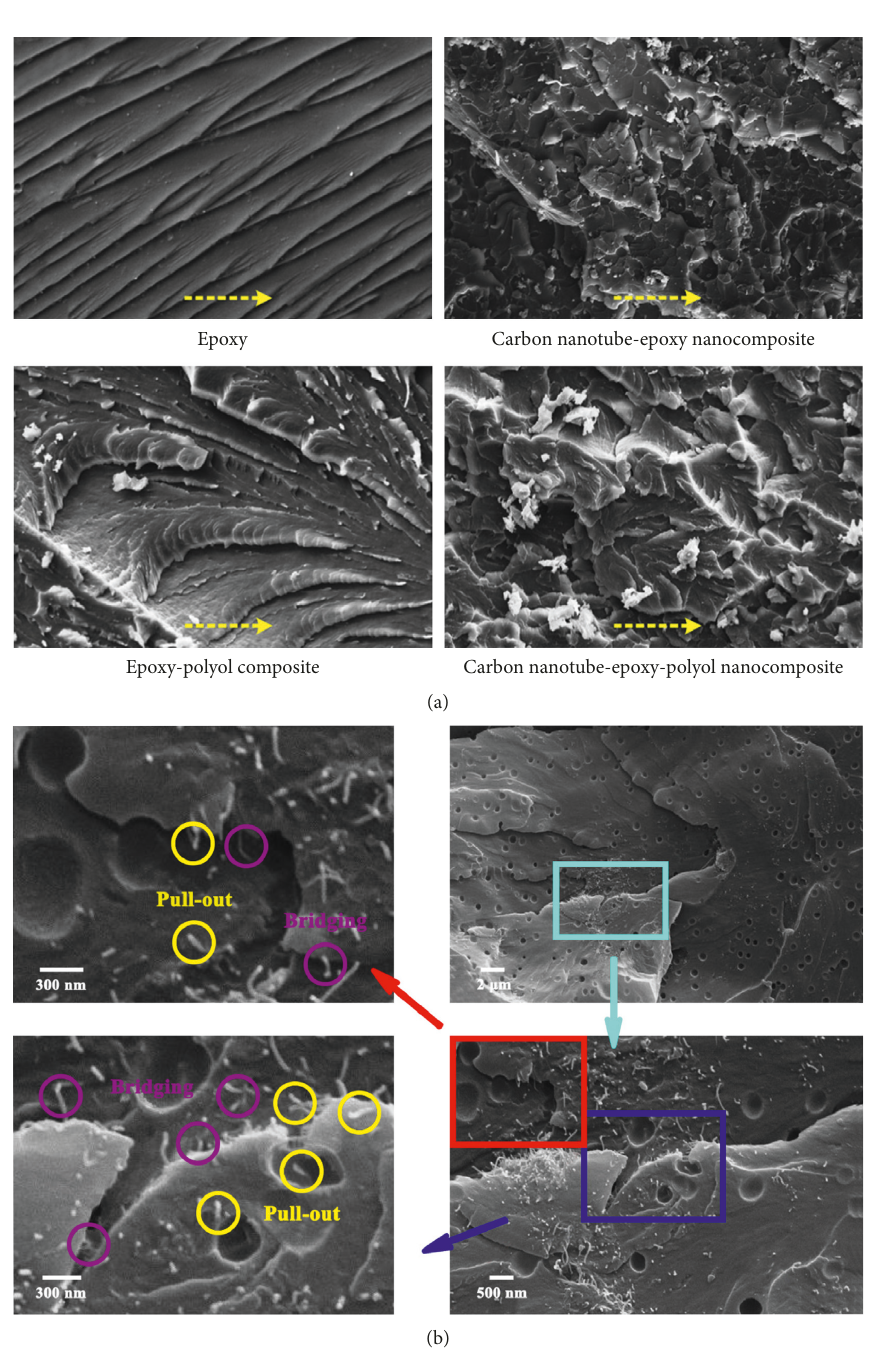
Figure 14: (a) Morphology of the quasistatically fractured surfaces characterized by a scanning electron microscope for neat epoxy and chemically modified epoxy composites. (b) Morphology of the quasistatic fracture surface characterized by a scanning electron microscope for an epoxy-polyol hybrid nanocomposite reinforced with multiwalled carbon nanotubes, illustrating a bridging phenomenon as well as the pull-out process of multiwalled carbon nanotubes from the polymer matrix (adapted with permission from reference [217]; copyright 2014, Elsevier